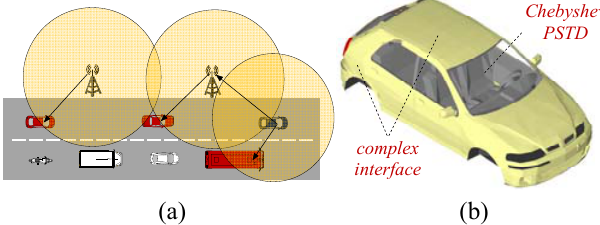
Figure 26: (a) A vehicle-to-vehicle communication link sce- nario and (b) the 3-D vehicle geometry. Modeling regions: complex-interface schemes for the outer surfaces, optimized FVTD technique for the external space and the PML, and PSTD algorithm for the interior of the